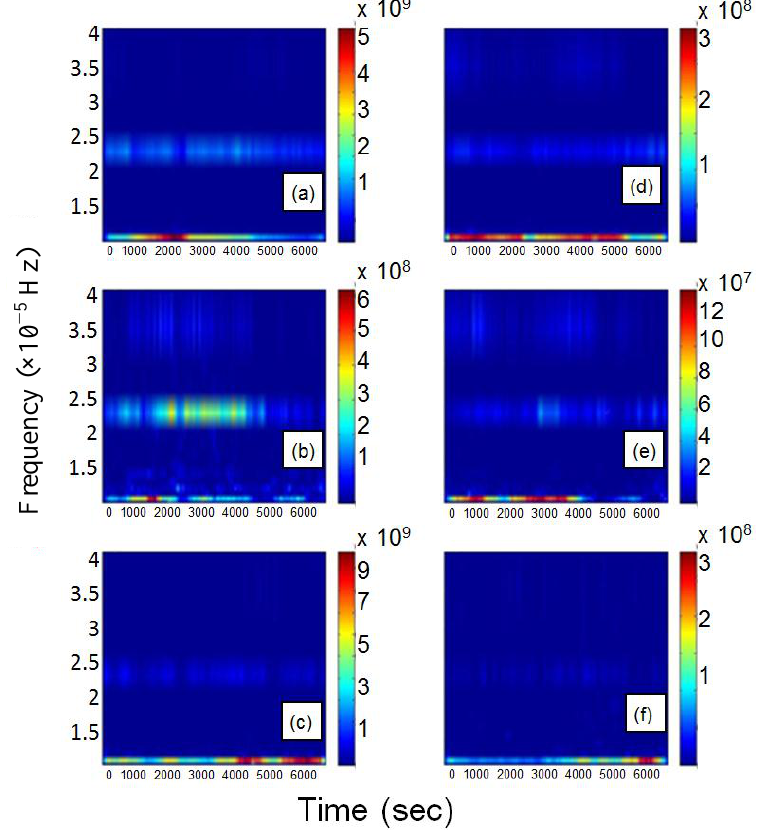
Figure 3. Time-frequency domain plot computed according to the WT-based method. ( a ) WT of the P 1 active power; ( b ) WT of the P 2 active power; ( c ) WT of the P 3 active power; ( d ) WT of the Q 1 reactive power; ( e ) WT of the Q 2 reactive power and ( f ) WT of the Q 3 reactive power.